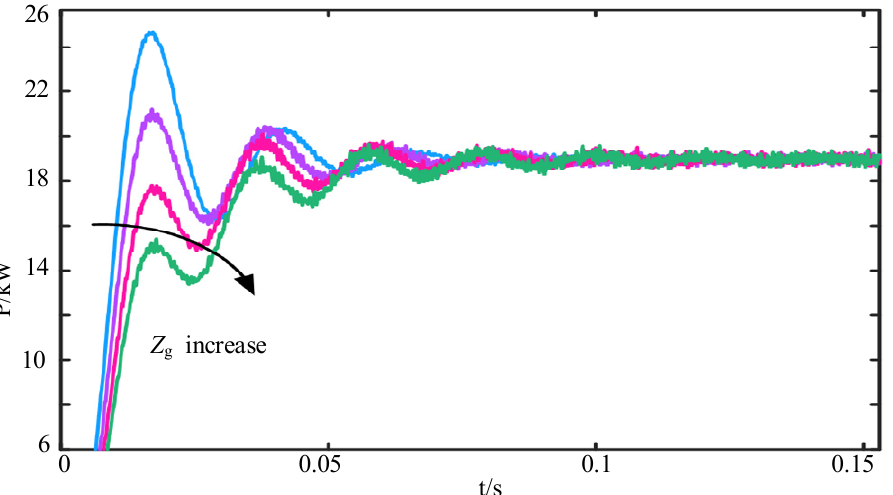
Figure 13. Simulation of grid impedance affecting system’s active output performance in weak grid.